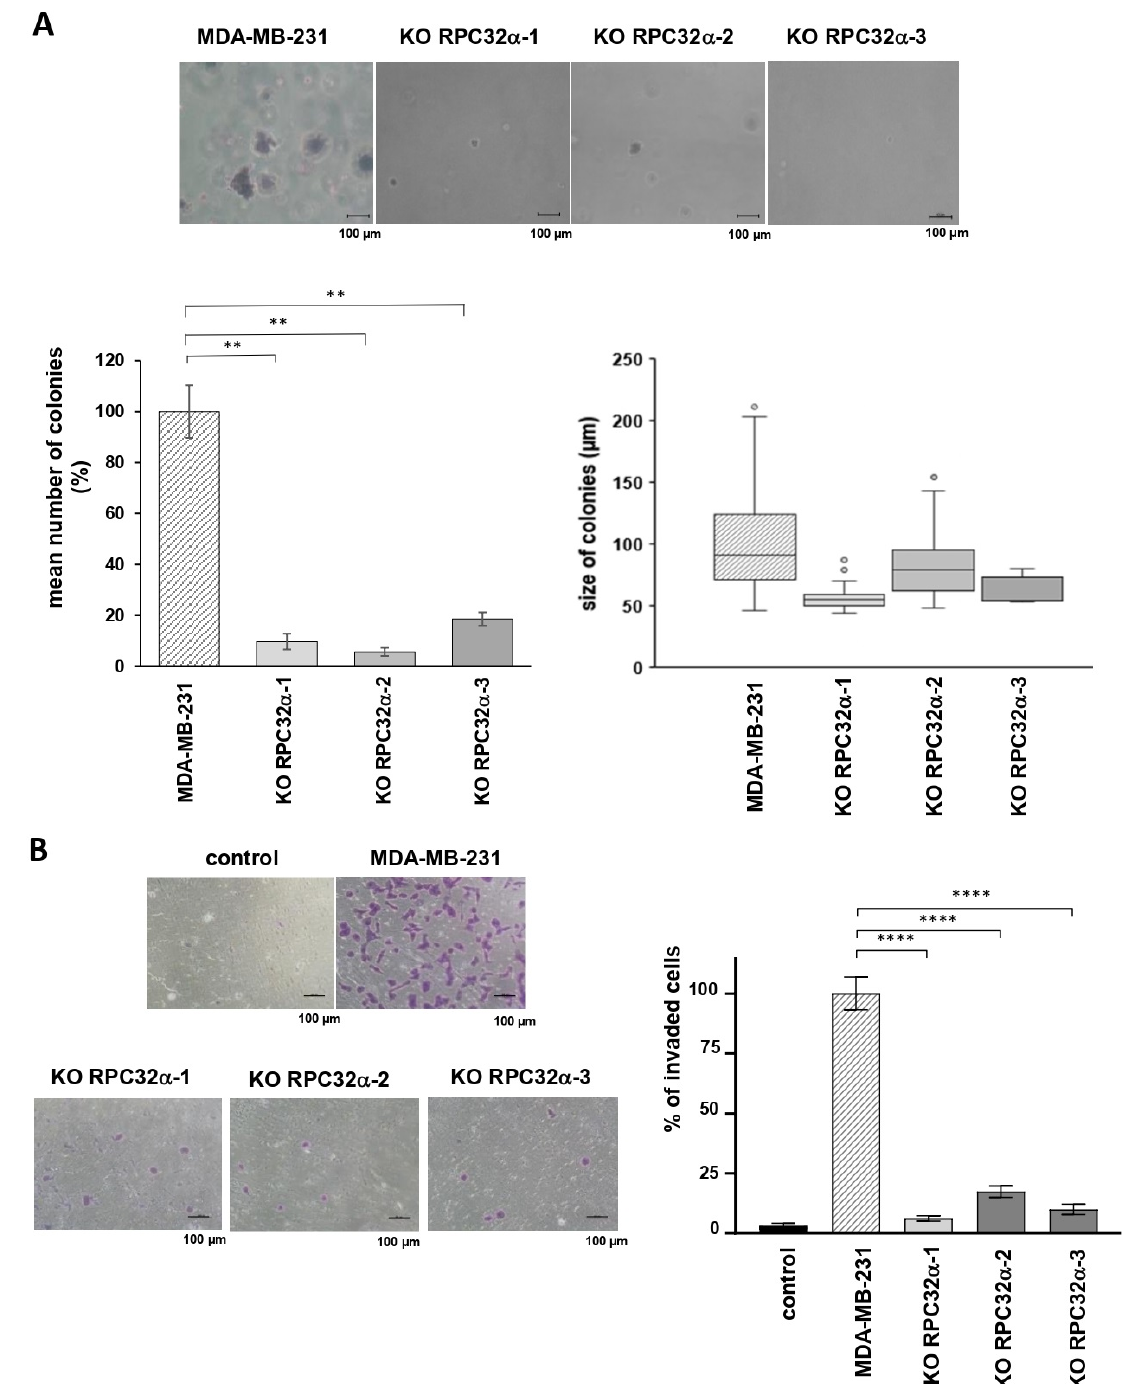
Figure 5. The POLR3G/RPC32 α knockout decreases tumorigenic and invasive capacities of MDA-MB-231 breast cancer cells in vitro. ( A ) Soft agar assays of MDA-MB231 and POLR3G KO (3GKO) cell lines derived therefrom. The top row shows representative microscope images of colonies stained with crystal violet. The graphs in the bottom row show relative mean numbers (left) and the mean size (right) of colonies formed by MDA-MB-231 and 3GKO cell lines (three independent experiments). ( B ) Transwell cell invasion assays with MDA-MB231 and 3GKO cell lines derived therefrom. Representative microscope images are shown to the left. Scale bar: 100 µ m. Percentage display of colony quantifications is shown to the right. Data are presented as the mean of three independent experiments ± SEM (** p < 0.01 and **** p < 0.0001 compared with